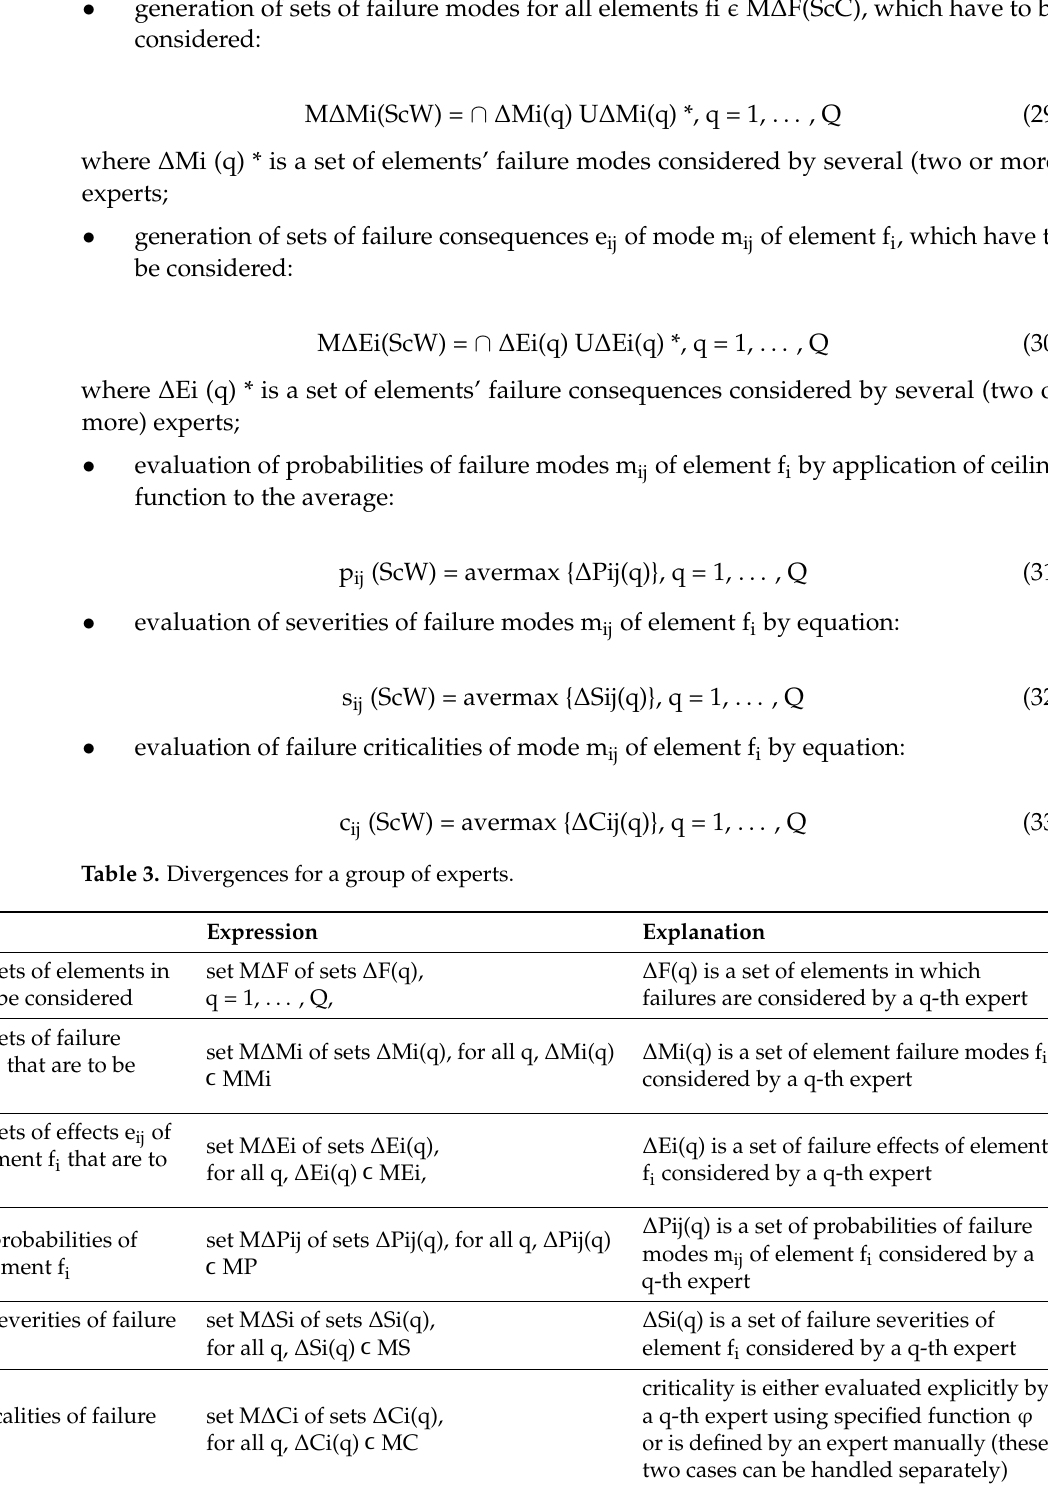
Figure 2. Relation between failure cause, modes, and effects.